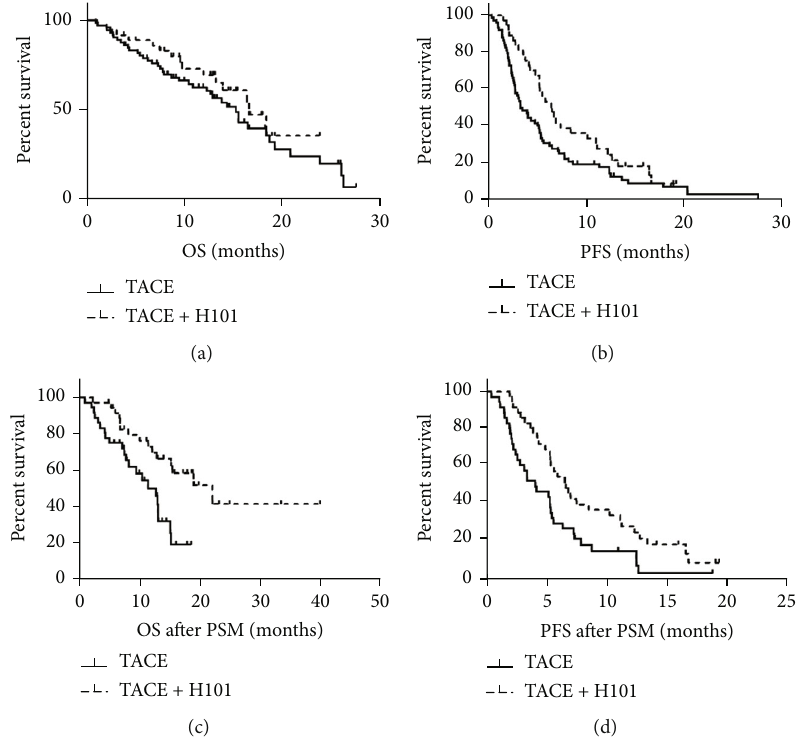
Figure 1: Kaplan – Meier survival curves for OS/PFS within unresectable HCC cases. OS for unresectable HCC patients having H101-TACE and cTACE cohorts (37 cases vs. 74 cases) prior to PSM (a) ( P = 0 : 043 ); PFS within H101-TACE and cTACE cohorts (37 cases vs. 74 cases) prior to PSM (c) ( P = 0 : 046 ); OS for unresectable HCC cases with H101-TACE and cTACE cohorts (36 cases vs. 36 cases) following PSM (b) ( P = 0 : 004 ); PFS within H101-TACE and cTACE cohorts (36 cases vs. 36 cases) following PSM (d) ( P = 0 : 012 ). H101-TACE: transarterial chemoembolization combined with H101; cTAC: conventional transarterial